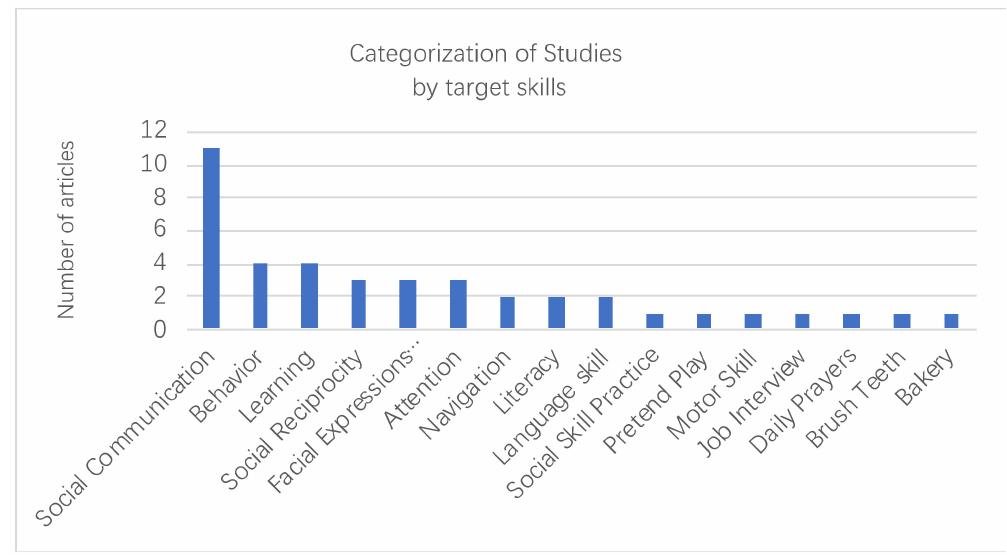
Figure 4. Publications per year and